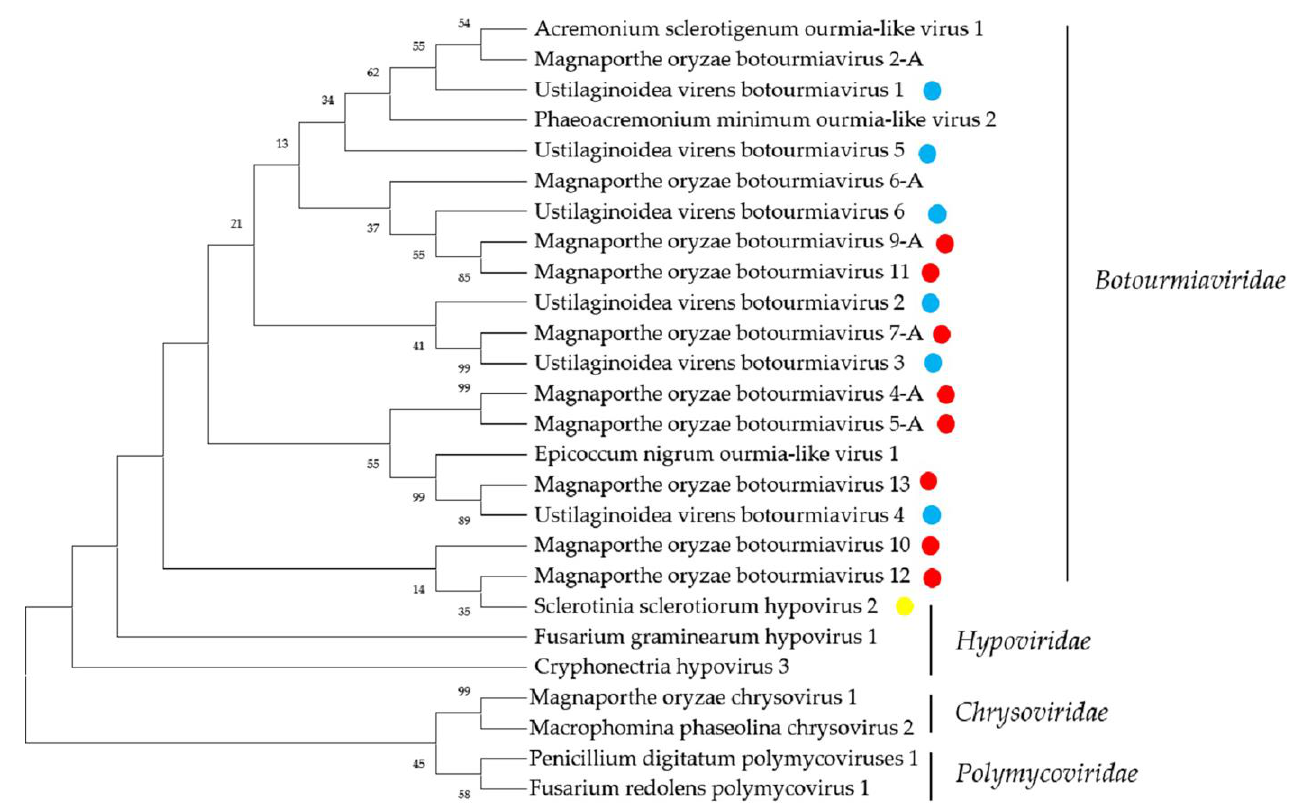
Figure 3. Phylogenetic analysis of viruses in the families Botourmiaviridae and Hypoviridae . Neighbor- joining-method phylogenetic tree based on the core RNA-dependent RNA polymerase (RdRP) motifs of putative viruses in the families Botourmiaviridae and Hypoviridae , other related viruses, and representatives of the two families. Viruses marked with red color are found in P. oryzae , blue color in U. virens , and yellow color in R. solani . The viruses without a color annotation are the representatives of the known species of each viral family.